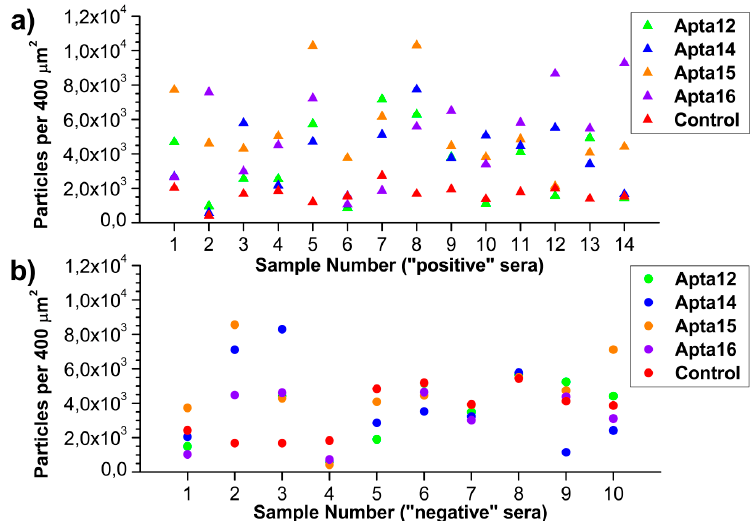
Figure 3. The number of objects registered on the apta-based AFM chip surface after the incubation in ‘positive’ ( a ) and ‘negative’ ( b ) serum samples. Color indicates the data obtained in control sensor area of the chip (red) and in working sensor areas with immobilized A12 (green); A14 (blue); A15 (orange); and A16 (violet) aptamers.